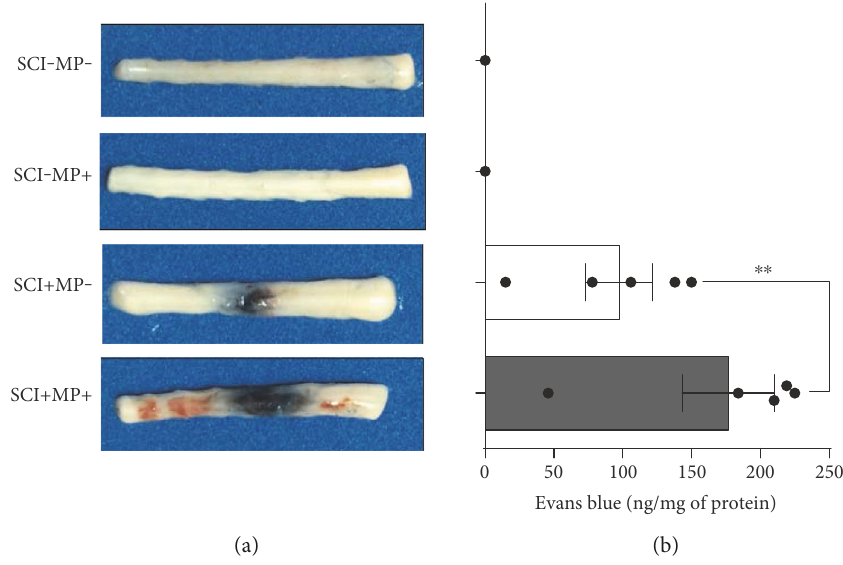
Figure 2: Evans blue extravasation is increased in rats subjected to SCI and treated with MP. (a) Representative photographs of spinal cord segments T5-6 to L1-2 showing the lesion caused by SCI 24 h after contusion and the extravasated Evans blue ( n = 5 per group). Sham- operated animals do not have any trace of Evans blue in the spinal cord parenchyma; however, the accumulation of this tracer at the site of injury is evident in animals subjected to SCI. MP worsen BSCB disruption causing a further accumulation of the dye at the site of injury. (b) Fluorescence quanti fi cation of the extravasated Evans blue shows a notable increase of ~ 80% parenchymal Evans blue in animals treated with MP related to injured rats administered with vehicle alone. Bars are the mean ± SEM of 5 spinal cord segments; dots show individual data measurements. ∗∗ p < 0 01 .